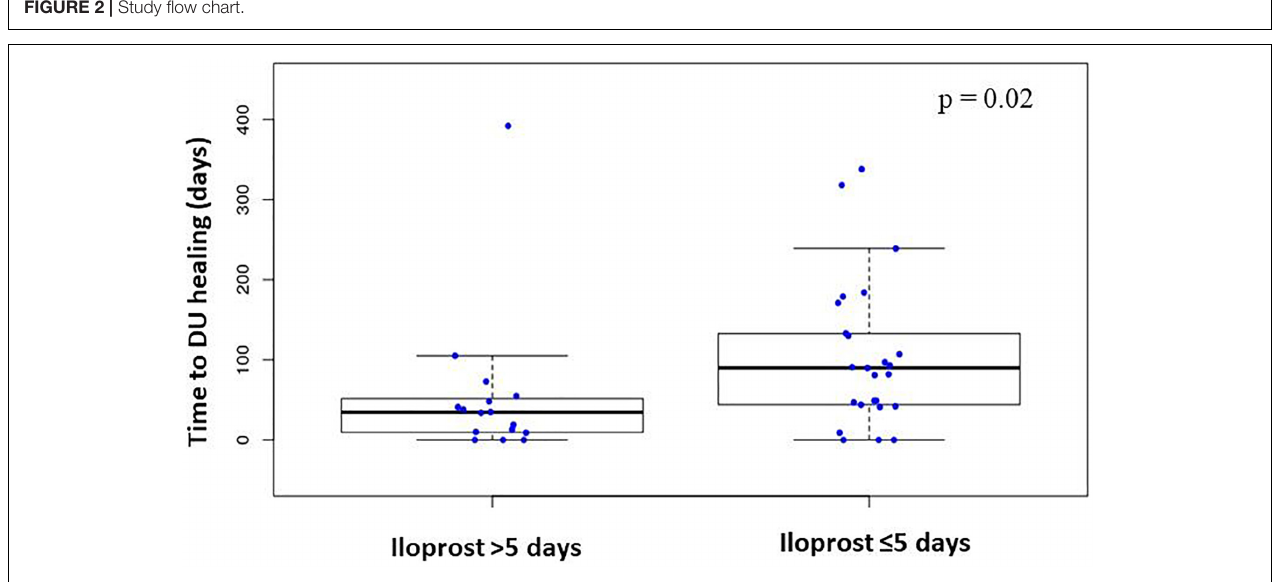
FIGURE 2 | Study flow chart.